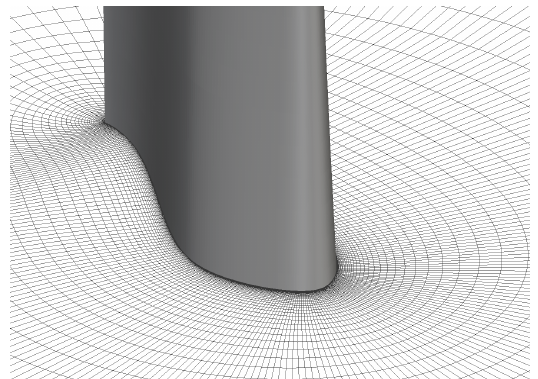
Figure 2. View onto the grid at the pressure side of the rotor